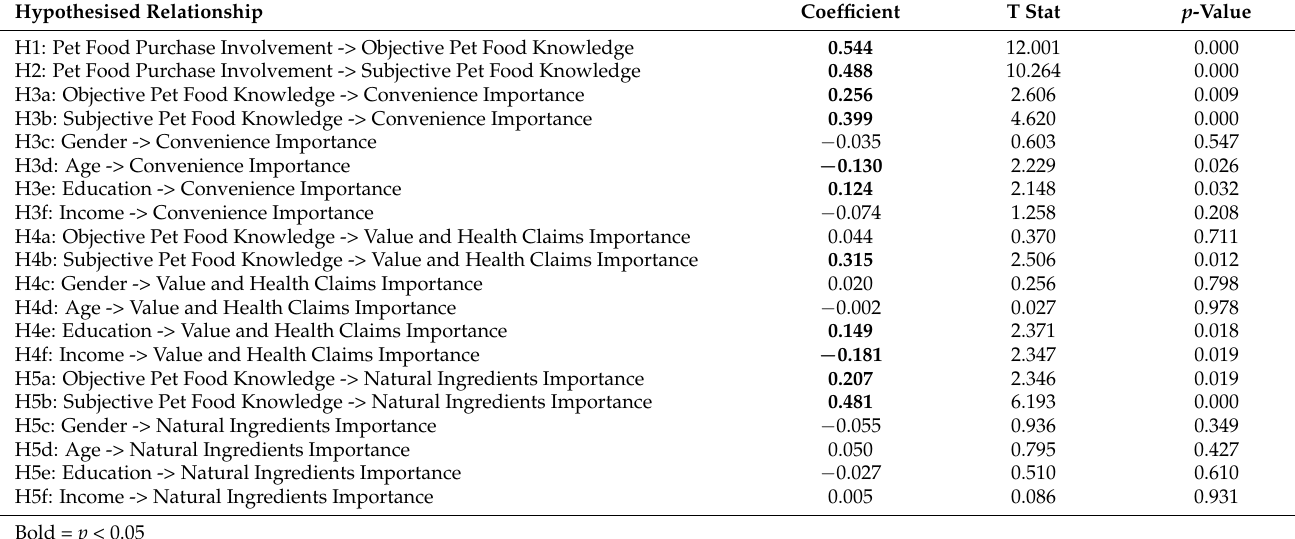
Table 4. Path Coefficients/Hypothesis Testing Results.